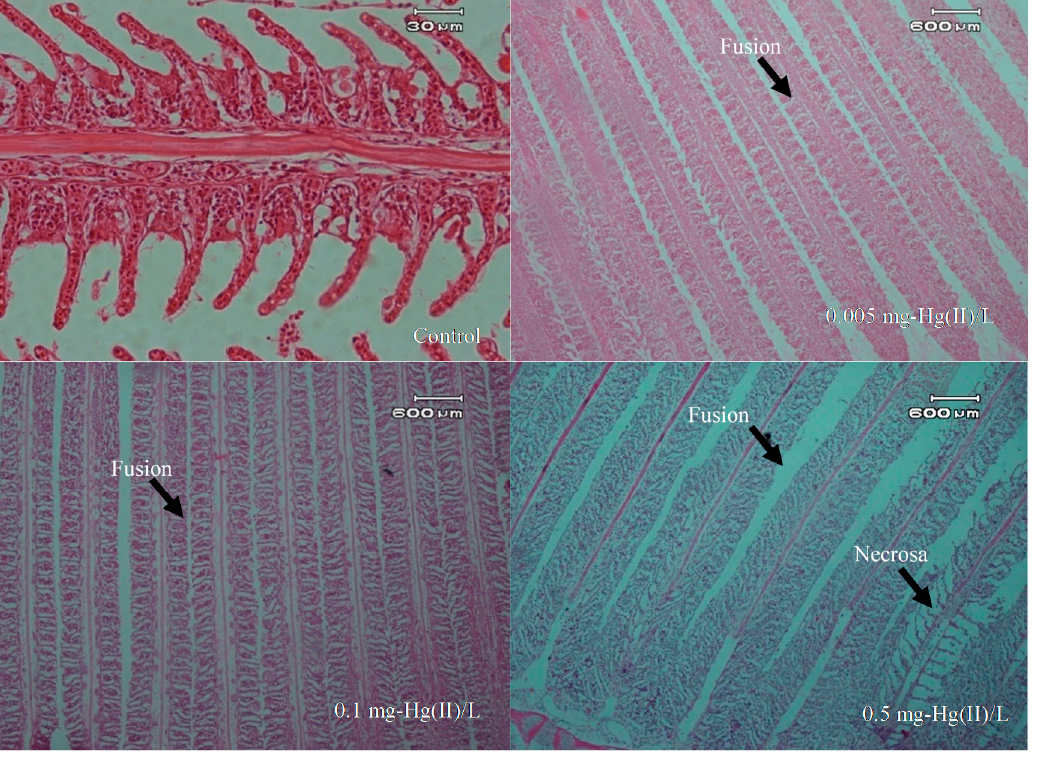
Figure 3. Photomicrograph description of freshwater fish ( Oreochromis niloticus ) after exposure to Hg(II) (20 ×